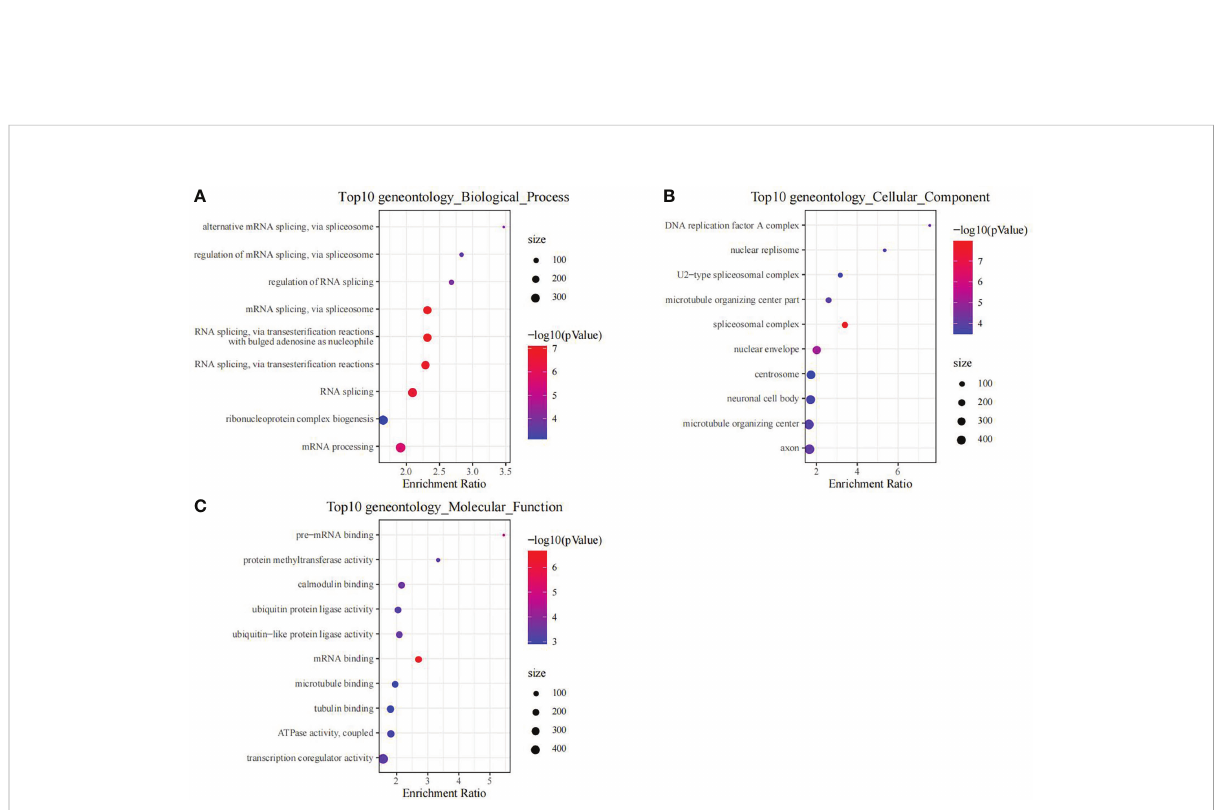
FIGURE 6 The functional analysis of downregulated DEGs between OP samples and normal samples in training set. GO biological process (A) , GO cellular component (B) and GO molecular function (C) enrichment analysis of DEGs.